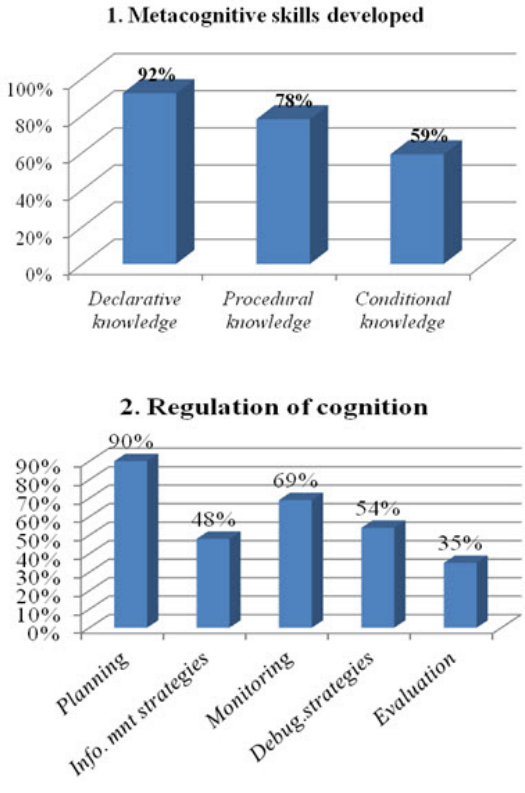
Figure 2. Meta-cognition awareness development (at the end of the experimental